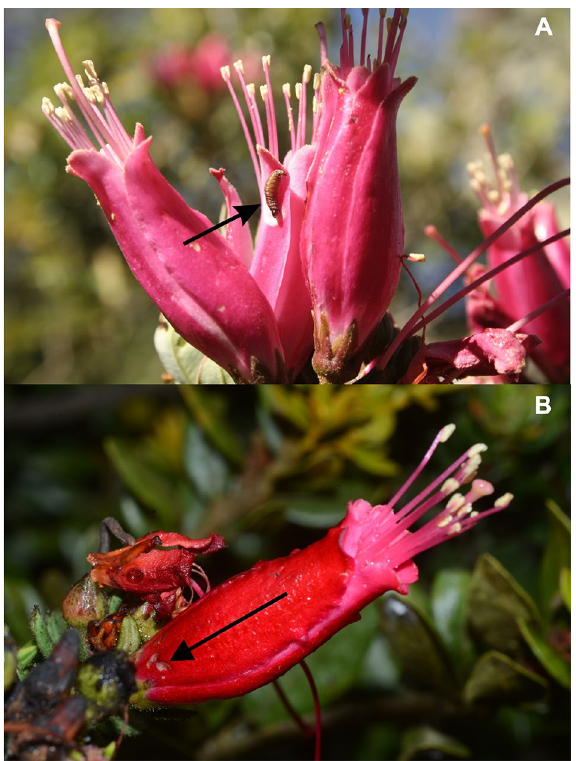
Figure 8. ( A ) Moth larvae trapped on the sticky surface of petals of Bejaria resinosa. ( B ) Flower showing the marks left after a visitation by the avian nectar robber Diglossa